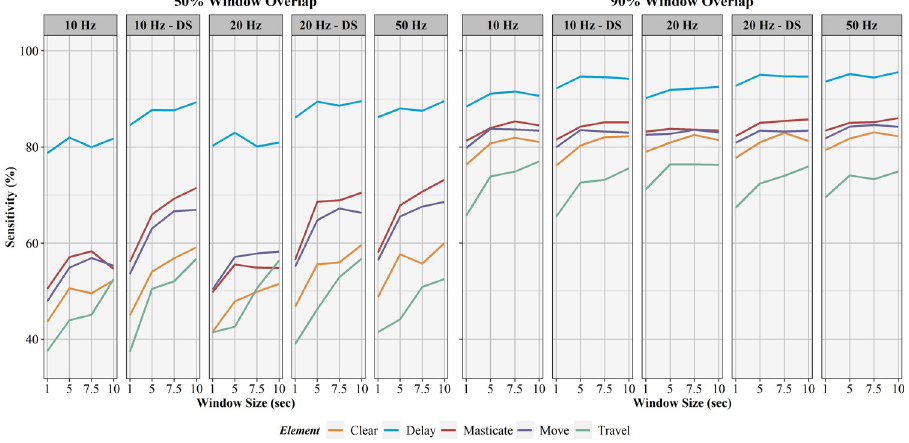
Fig 6. Sensitivity results for activity recognition models. Comparison of activity recognition model sensitivity percentages for 50% and 90% sliding window overlaps across the four sliding window lengths (1, 5, 7.5, 10 seconds) for each work element (clear, delay, masticate, move,